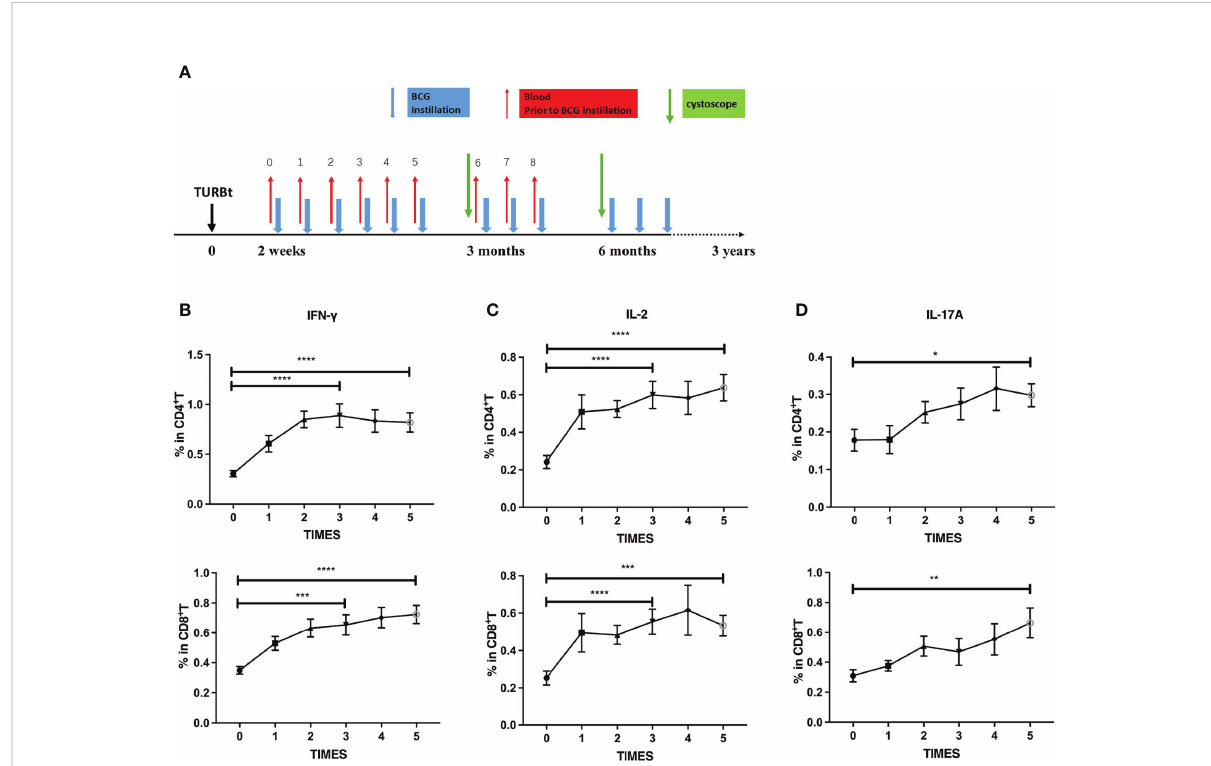
FIGURE 2 Dynamics of PPD-speci fi c cytokine production in T cells at the induction phase. (A) Scheme of intravesical BCG instillation and blood sample collection in this study. Red arrows: blood sample collection (before each BCG instillation); Blue arrows: BCG instillation. (B – D) Dynamics of PPD-speci fi c IFN- g (B) , IL-2 (C) and IL-17A (D) producing CD4 + (up) or CD8 + T (down) cells at the induction phase from BCG responding BC patients (N = 27). Data are represented as the mean ± SEM. The P values were calculated using analysis of variance. * P < 0.05, ** P < 0.01, *** P < 0.001, **** P <